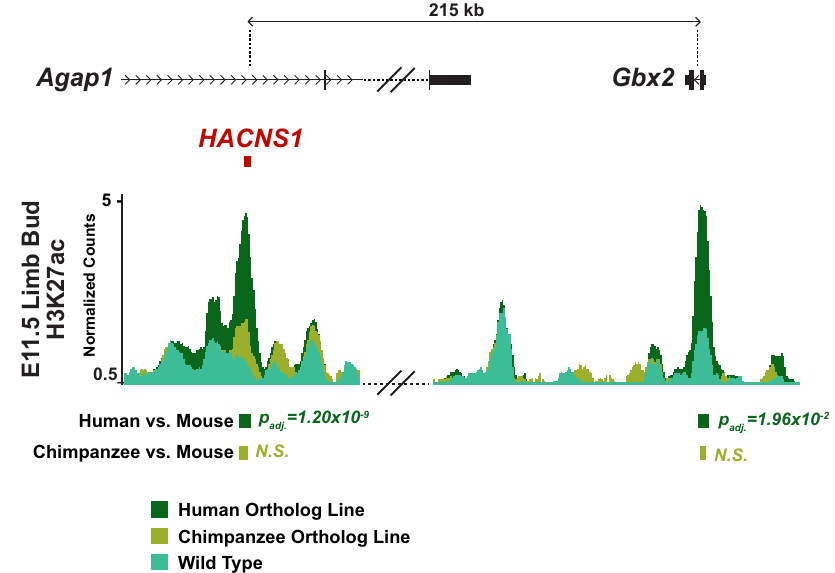
Fig. 2 Epigenetic signatures of increased activity at HACNS1 and the Gbx2 promoter in the HACNS1 homozygous mouse limb bud. Epigenetic pro fi ling in the HACNS1 homozygous E11.5 limb bud compared to the chimpanzee ortholog line and wild type. The normalized H3K27ac signals are shown for the HACNS1 line (in dark green), the chimpanzee ortholog line (in olive), and wild type (in teal) (see “ Methods ” ). The location of the edited HACNS1 locus in the human ortholog line relative to nearby genes is shown above the track. The double slanted lines indicate intervening H3K27ac signal data between the edited and wild type loci and Gbx2 that were removed for clarity; see Supplementary Fig. 2 for complete views for each line as well as input signals. H3K27ac peak calls showing signi fi cant increases in signal between HACNS1 homozygous and wild type, and the corresponding peak regions compared between the chimpanzee control line and wild type, are shown below the signal track. Litter-matched embryos were used for each comparison (see “ Methods ” ). N.S. not signi fi cant. All peak calls for each line are shown in Supplementary Fig. 2. Adjusted P values were obtained using DESeq2 (implemented in HOMER) with a Wald test followed by Benjamini-Hochberg correction 23,24